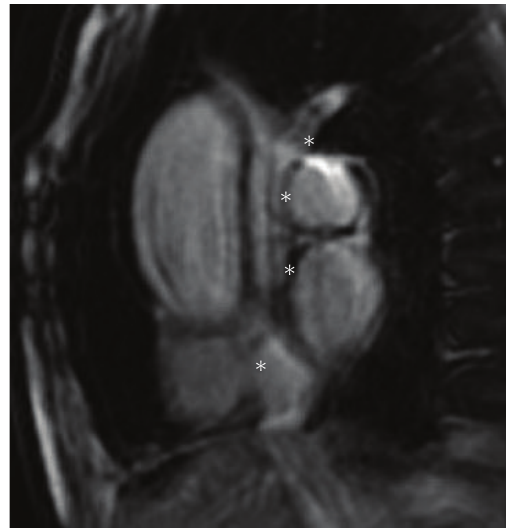
Figure 3: MRI showing the entire course of the thrombus ( ∗ ) from the left brachiocephalic vein, SVC, and finally to the right atrium.